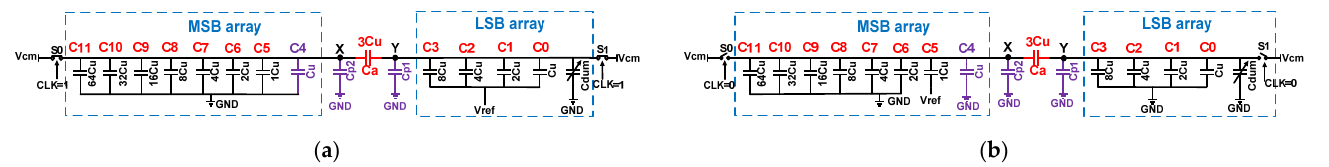
Figure 3. The DAC capacitor array during the calibration. ( a ) Sampling Vref in the LSB array; ( b ) the charge distribution.